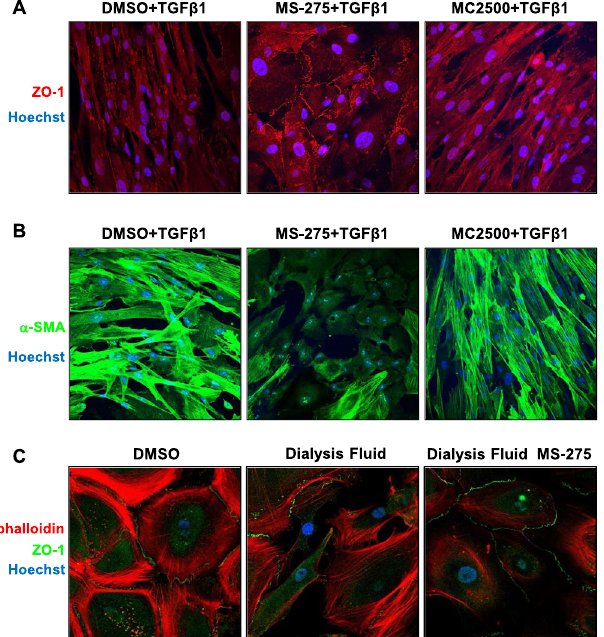
Figure 4. MS-275 promotes ZO-1 plasma membrane localization, α -SMA downregulation and the reversal to an epithelial-like morphology independently of treatment with TGF β 1. Effect of MS-275 treatment on ZO-1 and α -SMA expression and localization. ( A ) MCs were treated with MS-275 (250 nM), MC2500 (250 nM) or DMSO for 72 hours. Moreover, cells were left untreated or stimulated with TGF β 1 for additional 24 hours. Only TGF β 1-treated cells are shown. Cells were fixed, permeabilized and stained with a polyclonal antibody against ZO-1. Images were acquired by confocal microscopy. Cell nuclei are shown in blue (Hoechst 33342). Confocal images are shown from one representative experiment of three performed. ( B ) MCs were treated as in ( A ). Cells were stained with a monoclonal antibody against α -SMA. Confocal images are shown from one representative experiment of three performed. ( C ) Effect of MS-275 on MMT induced by exposure to PD fluid. Epithelial-like MCs treated for four days with stay safe balance 4.25% and then treated with the same PD fluid in the presence of MS-275 for three more days. Alternatively, MCs were treated with stay safe balance 4.25% for seven days or left untreated for four days and then treated with DMSO for the last three days. Cells were fixed, permeabilized and stained with phalloidin and with a polyclonal antibody against ZO-1. Images were acquired by confocal microscopy. Cell nuclei are shown in blue (Hoechst 33342). Confocal images are shown from one representative experiment of three performed. Overlay images are shown. Single fluorescences are shown in Suppl. Fig. 6. P < 0.05 was considered